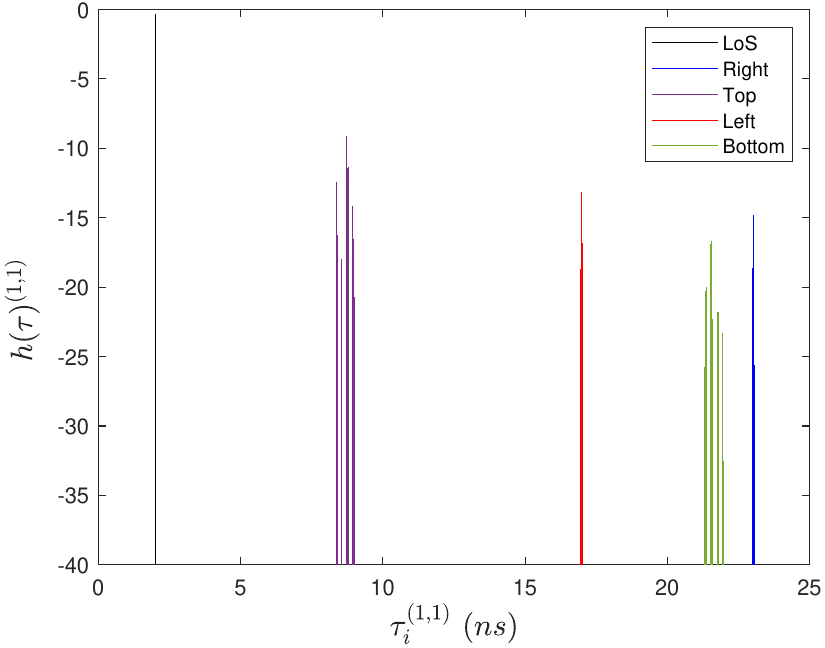
Figure 7. Set of channel impulse responses (CIRs) between the pair of antennas (1,1), considering a MIMO system with M = N = 4 and d MN = 1.0